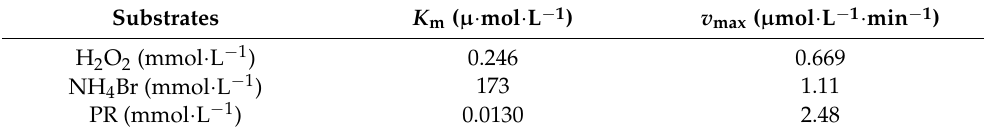
Table 1. The Michaelis–Menten constant ( K m ) and maximal reaction rate ( v max ) of N-C/CeO 2 composites. Substrates